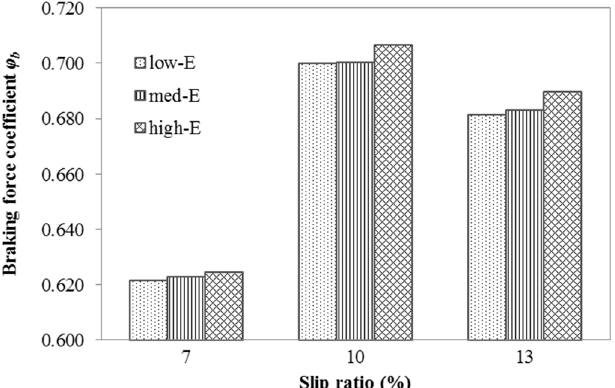
Figure 11. Pavement braking force coefficient under different slip ratios.